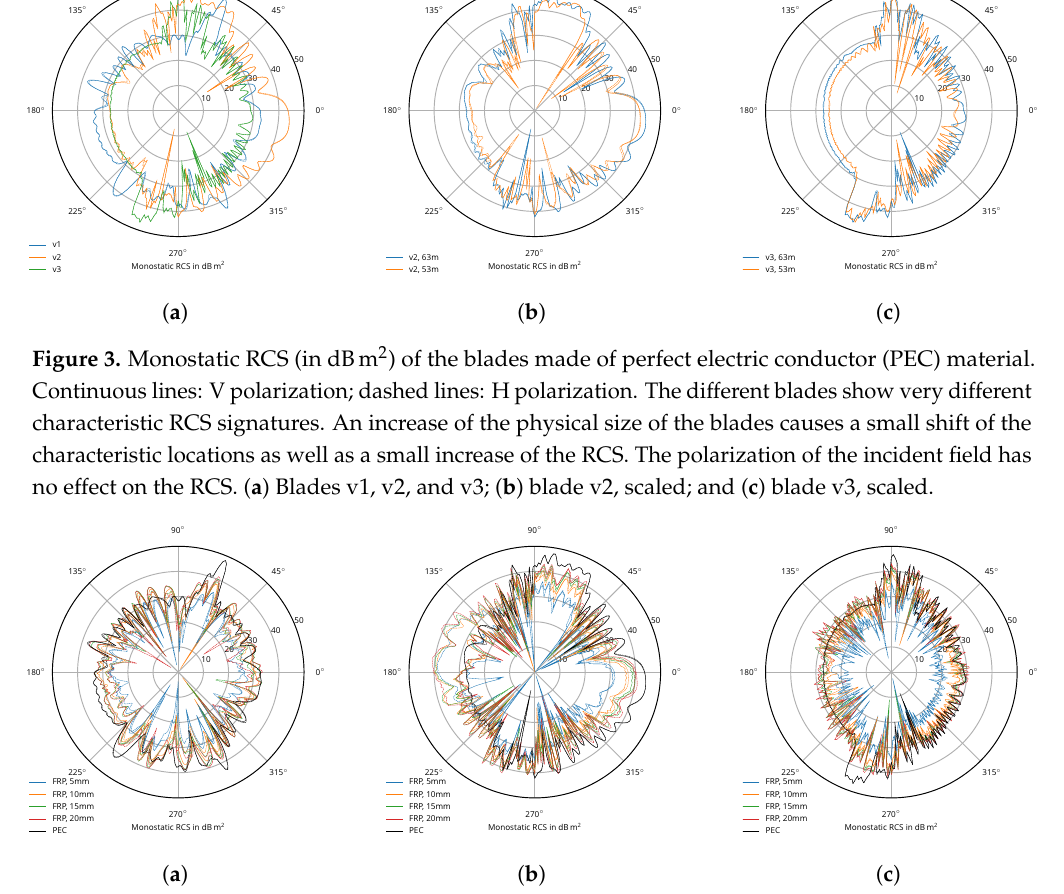
Figure 4. Monostatic RCS (in dBm 2 ) of the blades made of lossless fiber-reinforced plastic (FRP) of different thickness. Continuous lines: V polarization; dashed lines: H polarization. The polarization of the incident field has noticeable effects on the RCS, especially for blade v2, where the signal return is stronger than for a pure PEC model for H polarization. ( a ) Blade v1; ( b ) blade v2; and ( c ) blade v3.